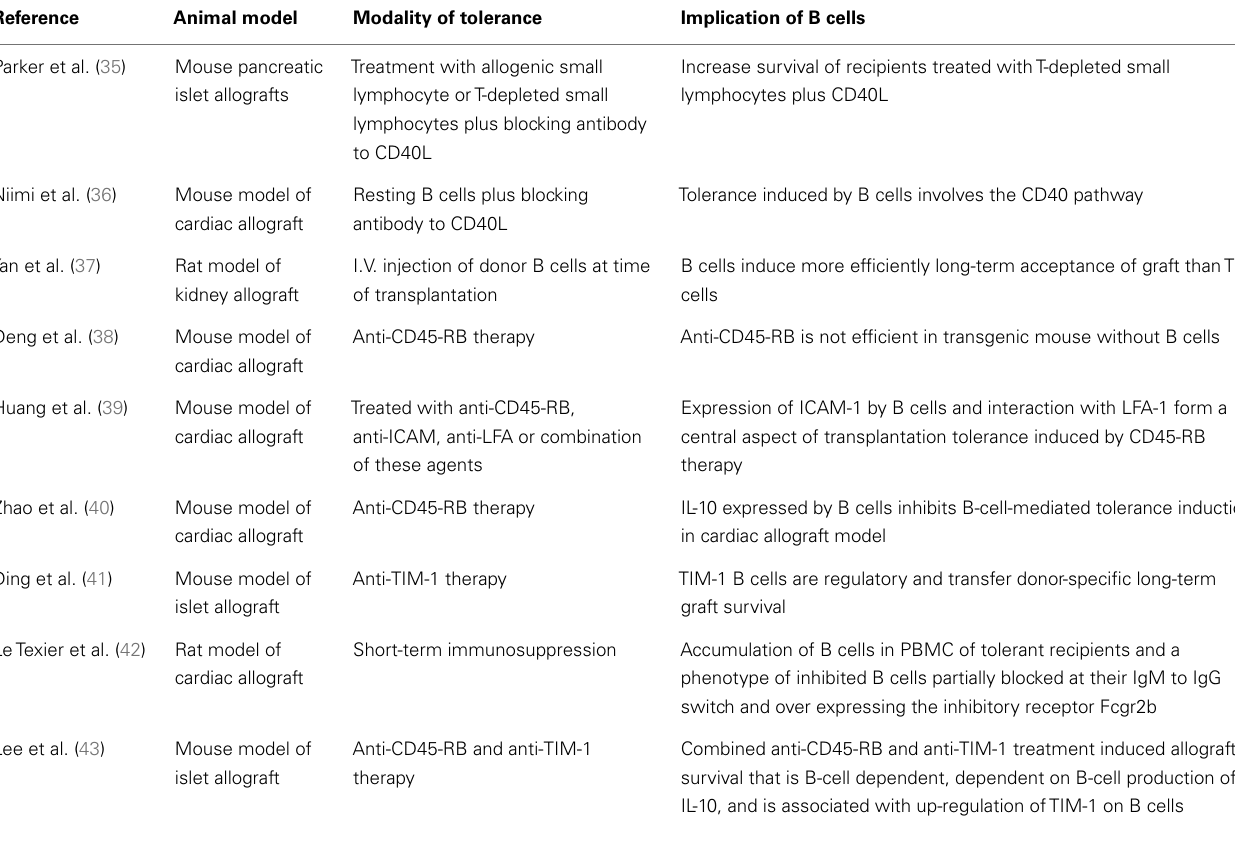
Table 1 | Summary table of studies demonstrating the implication of B cells as major actors in tolerance induction in different kinds of experimental animal